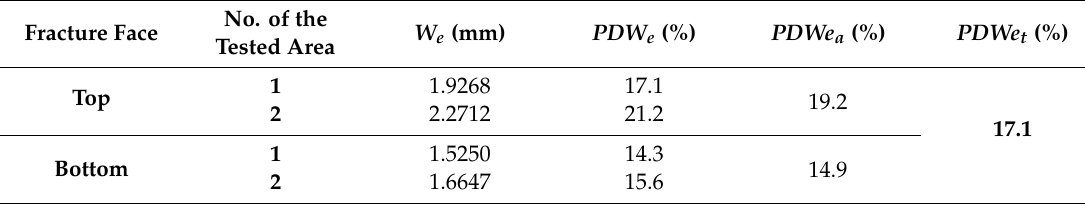
Table 3. Average percentage damage of the fracture surface—Test no.1.